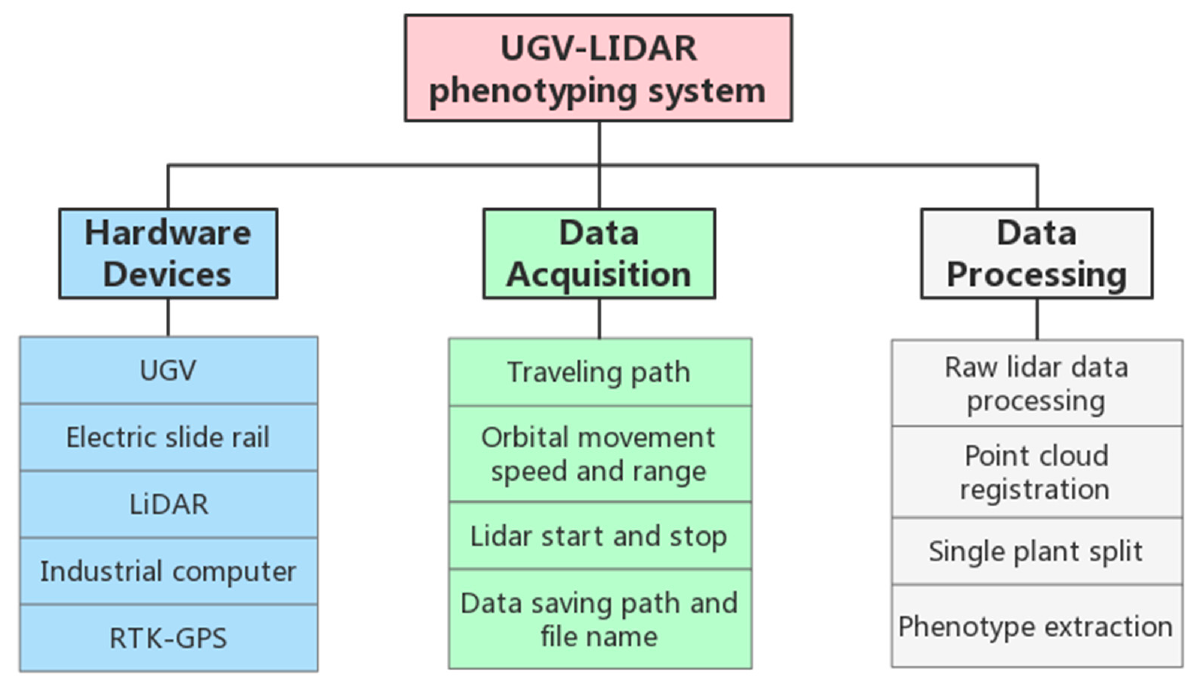
Figure 1. Composition of UGV-LiDAR phenotyping system.